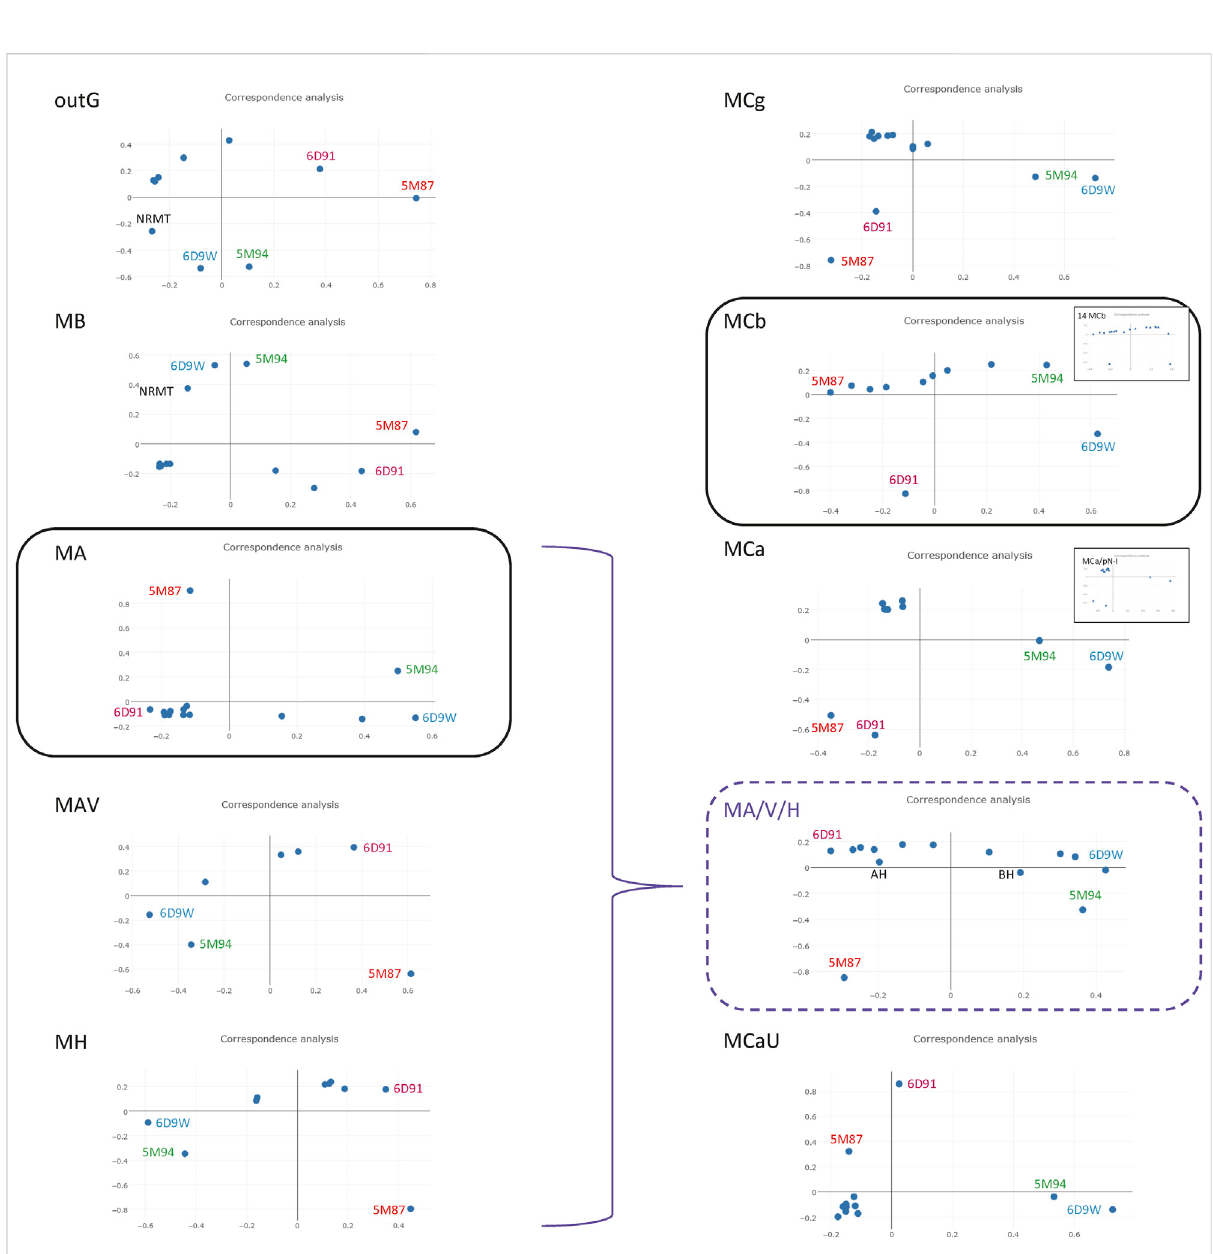
FIGURE 5 CorrespondenceanalysisofAF2conformerspredictedinindividualSlc11phylogroups.Amultidimensionalscalingmethodwasusedtoposition AF2 models with the most similar structural neighborhoods near each other (Holm, 2022). The known structures representing outward open and inward open conformations from phylogroups MntH A and MntH Cb served as references (6D91 and 5M87, and 6D9W and 5M94, respectively) as well as NRMT inward open template (7QIA) as indicated. Selected AF2 models from MA, MAV and MH were pooled to evaluate structural similarities across these phylogroups (highlighted in purple). Insets . Pooled MCa and plant pN-I (3) models; pool of 14 MCb predicted